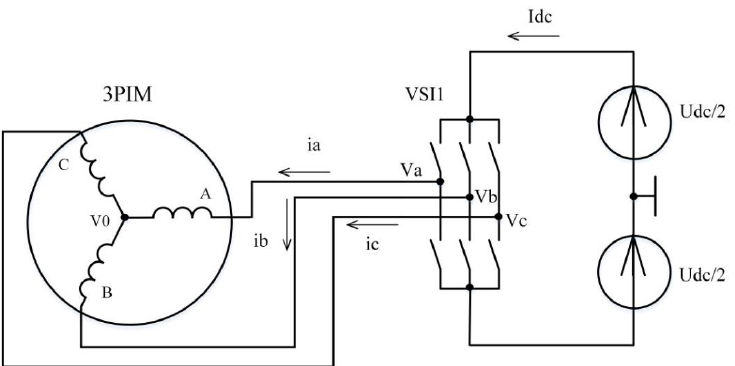
Figure 2. Block diagram of switch control-based IM.